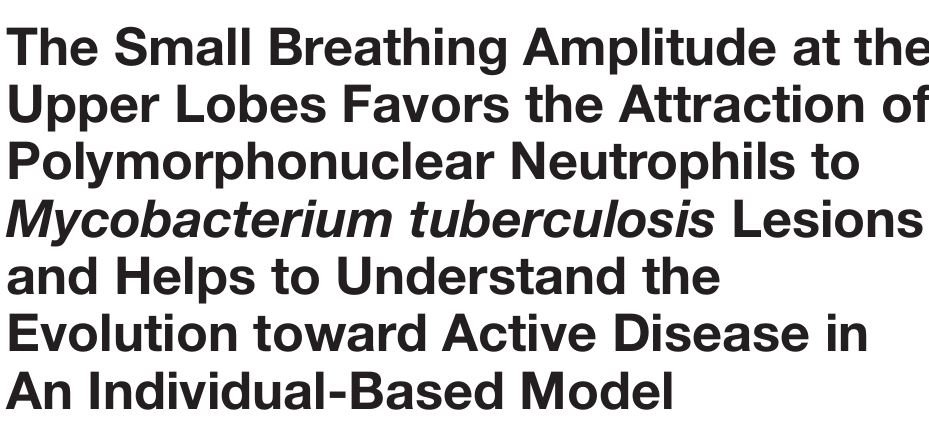
Cardona P-J and Prats C (2016) The Small Breathing Amplitude at the Upper Lobes Favors the Attraction of Polymorphonuclear Neutrophils to Mycobacterium tuberculosis Lesions and Helps to Understand the Evolution toward Active Disease in An Individual-Based